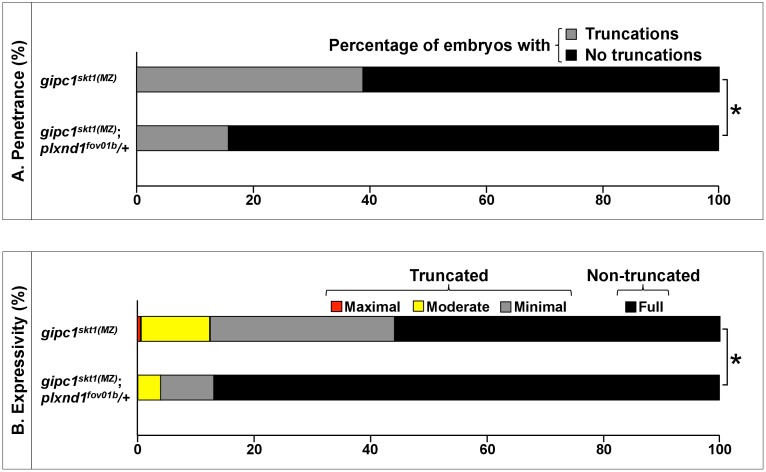
Penetrance and expressivity of Se-DLAV truncations in gipc1skt1(MZ) and gipc1skt1(MZ); plxnd1fov01b/+ embryos at 32 hpf.(A) Penetrance bar graph. Percentage of embryos of the indicated genotypes with Se-DLAV truncations (gray; a summation of the ‘minimal,’ ‘moderate,’ and ‘maximal’ categories) and with non-truncated Se-DLAV (black; ‘full’ category). The distributions of these two phenotypic classes were statistically significantly different between gipc1skt1(MZ) and gipc1skt1(MZ); plxnd1fov01b/+ embryos as assessed by a two-sided Fisher Exact test, p=0.0361. (B) Expressivity bar graph. Percentage of ‘maximal’ (red), ‘moderate’ (yellow), and ‘minimal’ (gray) Se-DLAV truncations and of ‘full’ (black) non-truncated Se-DLAV in embryos with Se-DLAV truncations of the indicated genotypes. The distributions of these four phenotypic classes were statistically significantly different between gipc1skt1(MZ) and gipc1skt1(MZ); plxnd1fov01b/+ embryos (brackets and asterisks) as assessed by a two-sided Fisher Exact test, p=0.00004. For additional supplementary information related to this figure, see Supplementary file 6. This figure is related to Figure 5.